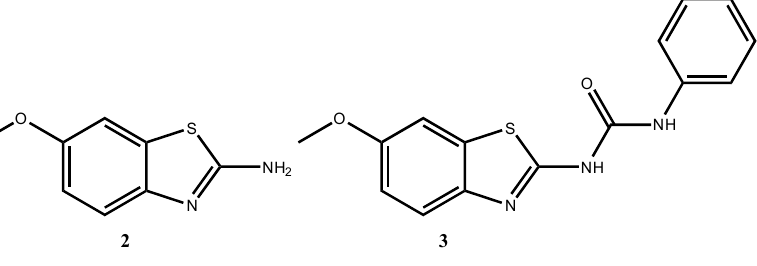
Figure 2. Structural formulas of Riluzole 2 and Frentizole 3 .